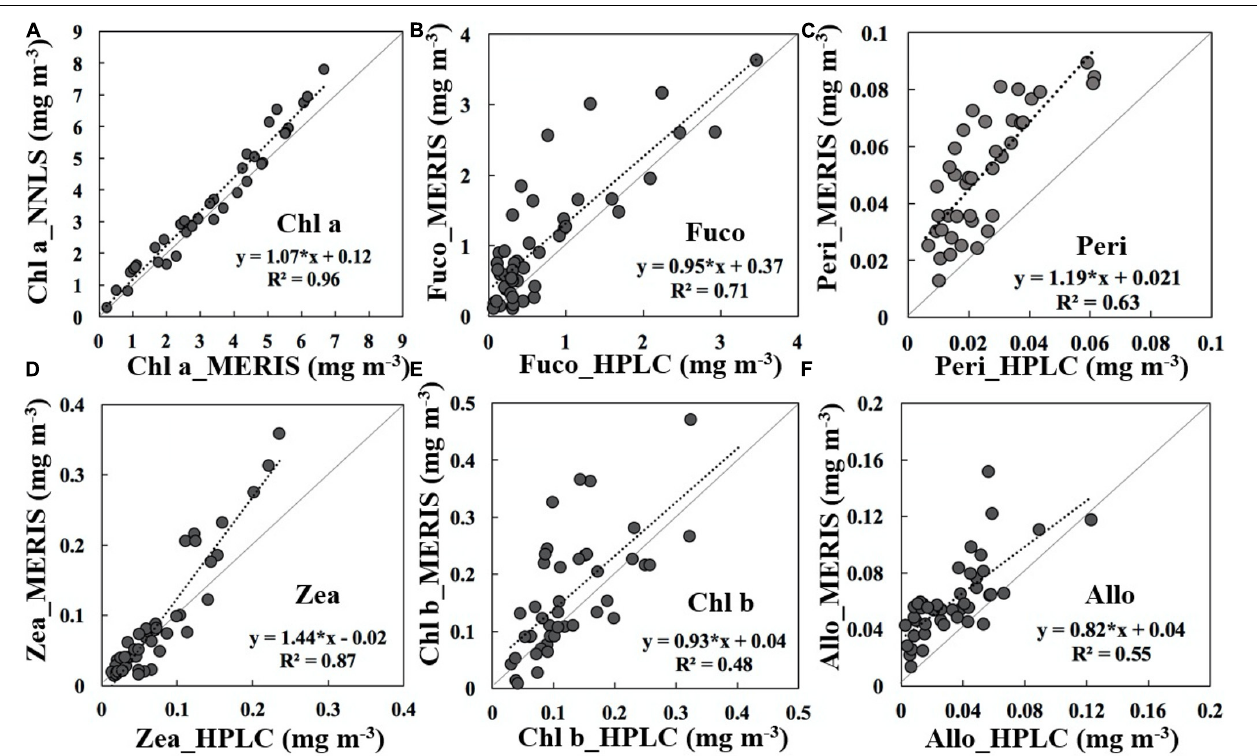
FIGURE 4 | Comparisons of MERIS-derived versus HPLC measured pigment concentrations from the 6, 19, and 48 week post-flood sampling trips in Moreton Bay: (A) Chl-a, (B) fucoxanthin (fuco), (C) peridinin (peri), (D) zeaxanthin (zea), (E) Chl-b, and (F) alloxanthin (allo). For all plots n = 46 and p < 0.001. Refer to Table 2 for taxonomic groups represented by these